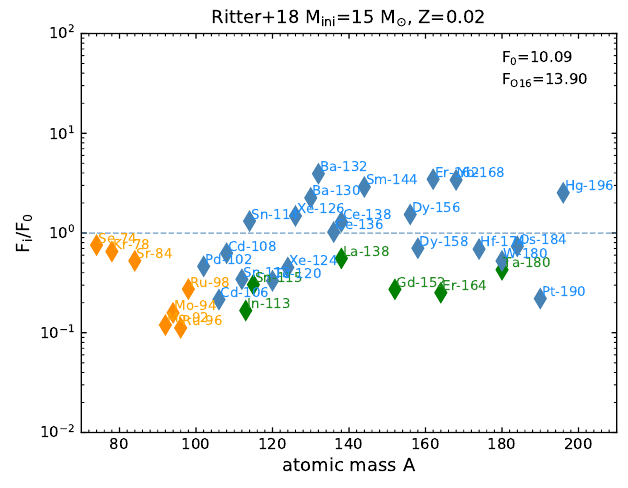
Figure 4. Same as Figure 2 but in the case of the star showed in Figure 3. In this case, there is a larger relative production of the isotopes that have an only γ –process